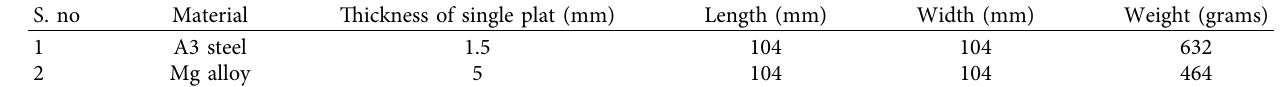
Table 3: Dimensions and weight of Swivel plate.